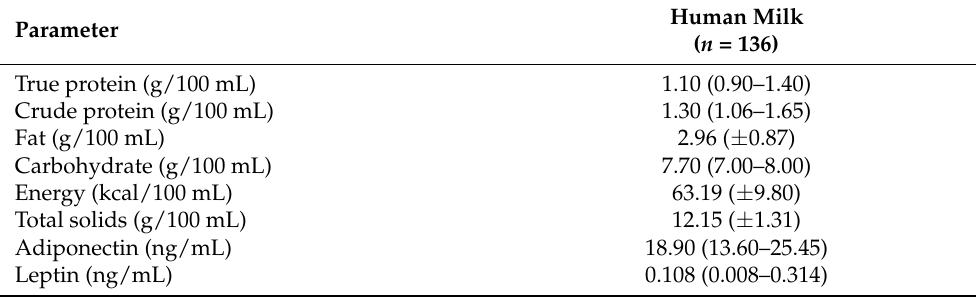
Table 2. Human milk nutrient